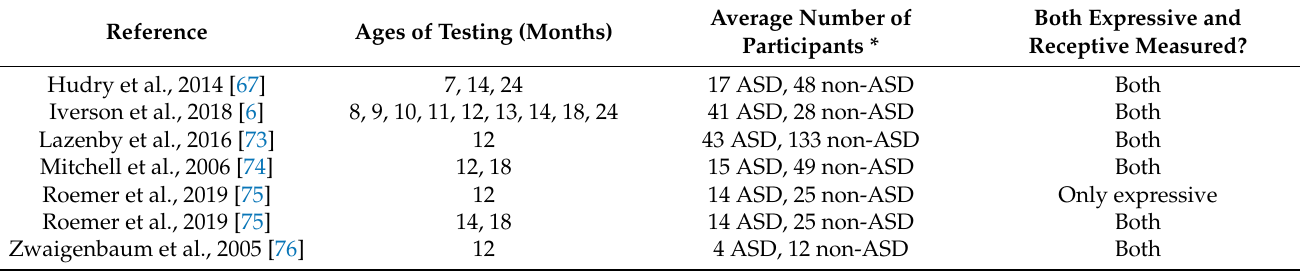
Table A3. Studies with clinical diagnosis on the MacArthur–Bates Communicative Development